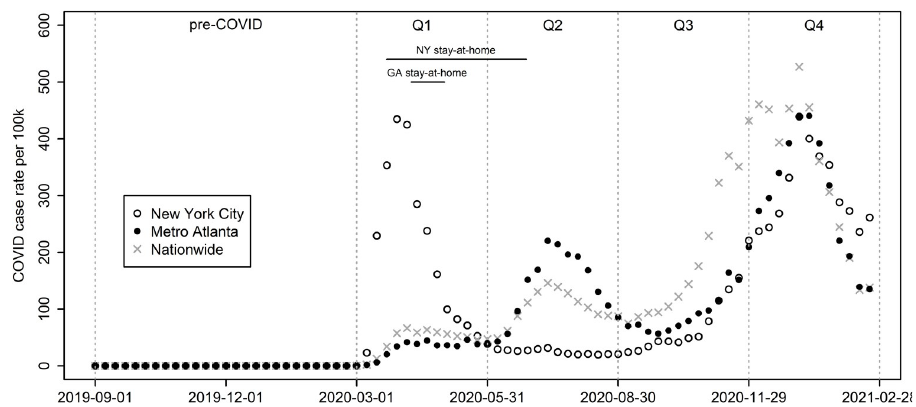
Fig 1. Weekly COVID-19 diagnoses. Sources: NYC Coronavirus Disease 2019 (COVID-19) Data Repository (https:// github.com/nychealth/coronavirus-data). Georgia Department of Public Health Daily Status Reports (https://dph. georgia.gov/covid-19-daily-status-report). The Centers for Disease Control and Prevention COVID Data Tracker (for national numbers https://covid.cdc.gov/covid-data-tracker/#trends_dailytrendscases). US Census Bureau Vintage 2020 Population Estimates for the United States and States (https://www.census.gov/programs-surveys/popest/technical- documentation/research/evaluation-estimates.html). COVID-19 US state policy database [www.tinyurl.com/ statepolicies,